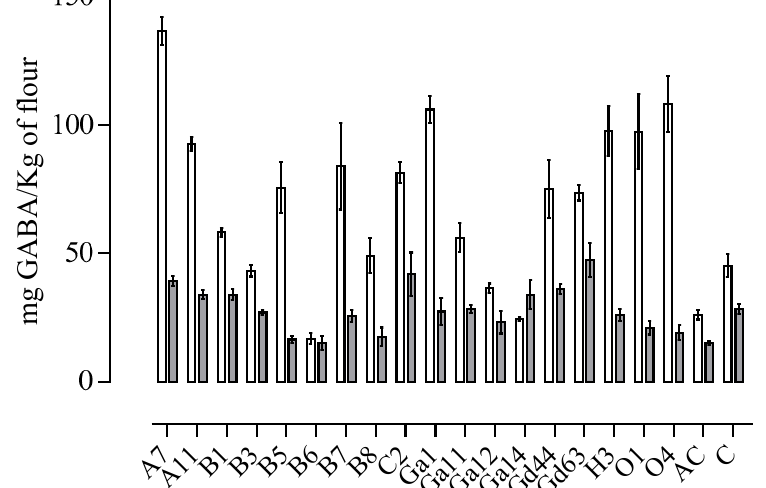
Figure 1. Production of GABA after 6 h fermentation in wheat (white bar) and amaranth (grey bar) sourdoughs obtained with 18 lactobacilli strains singly inoculated (data are expressed as mean ± coefficient of variation %). C—control; AC—acid control.